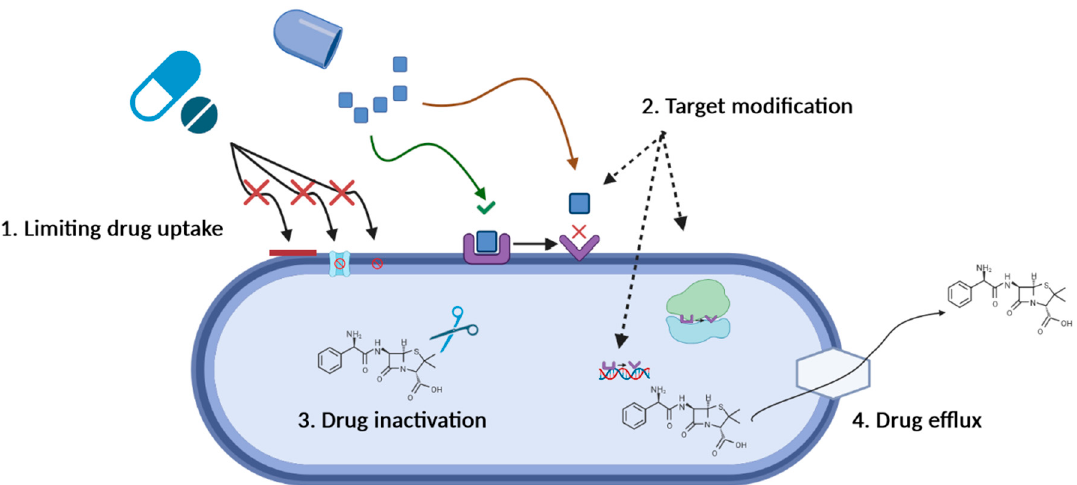
Figure 1. Main mechanisms of antimicrobial resistance (created with BioRender.com): 1. limiting drug uptake (e.g., thickened cell wall, porin mutation, porin downregulation.); 2. target modification (e.g., penicillin-binding protein modification in the bacterial membrane, target modification during nucleic acid synthesis or ribosomal methylation); 3. drug inactivation (e.g., by betalactamases); 4. drug efflux through active pumps.